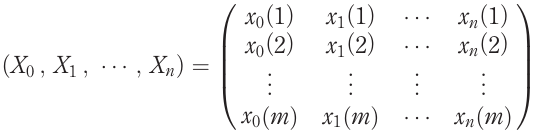
3.2.2 Grey correlation method. The grey relational model assesses the consistencies between two systems and is therefore suitable for evaluating dynamic change processes. As each system in the model is a grey system with incomplete information and messy data characteristics, the grey correlation model can comprehensively assess the complete system information by analyzing and researching the “ partly known poor information ” within the grey system (Kuo et al. , 2008). The LCCE ’ s multiple subsystems: economic development, social progress, energy consumption, low-carbon emissions, carbon sink capacity and environmental carrying capacity: are subject to synergy and have internal interactive and uncertain relationships. Therefore, the relationships between the various systems are de fi ned as grey relationships, for which a grey correlation model is used to measure the LCCE development level, as